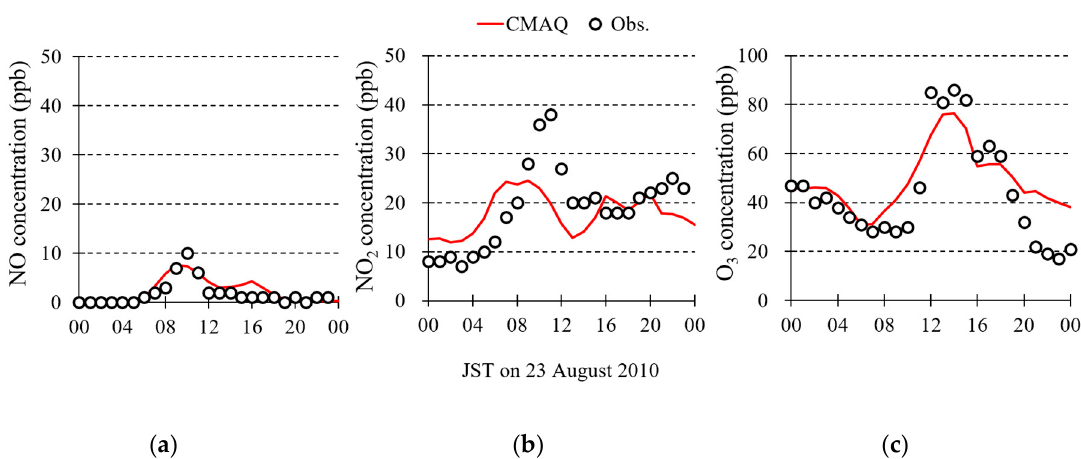
Figure 4. Diurnal variations of Community Multiscale Air Quality model (CMAQ)-simulated and observed ( a ) NO, ( b ) NO 2 , and ( c ) O 3 concentrations at the Kokusetsu-Osaka station for monitoring ambient air pollution on 23 August 2010.